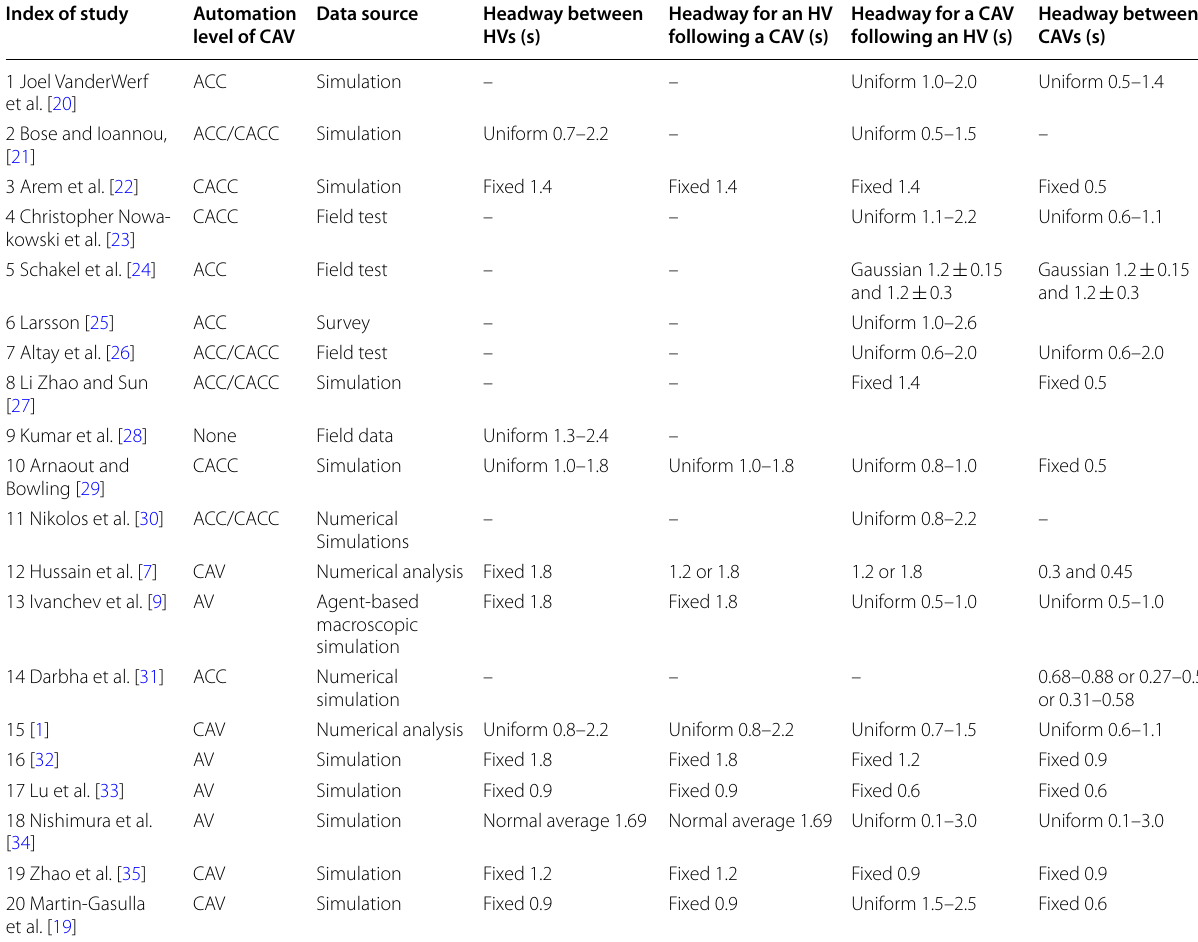
Table 2 Studies about headway distribution in mixed